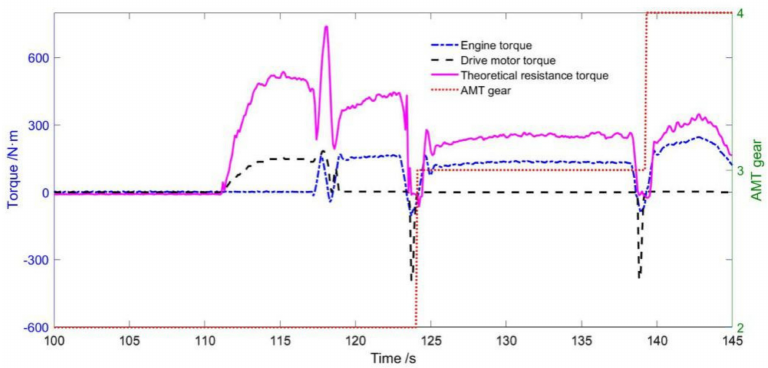
Figure 18. The torque of engine, motor, and